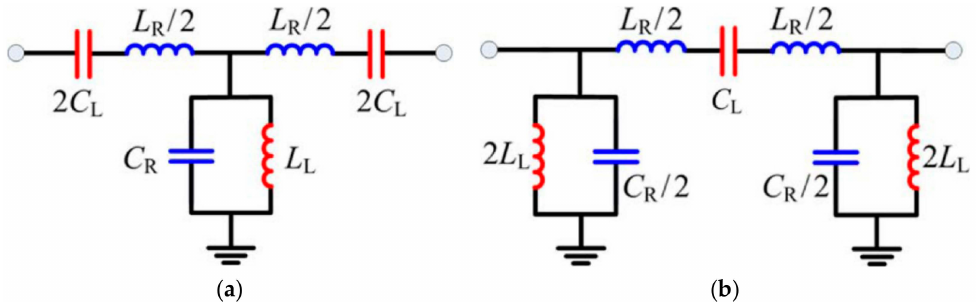
Figure 9. Equivalent circuit models for the symmetrical CRLH-metamaterial unit-cells. ( a ) T -type circuit model. ( b ) π -type circuit